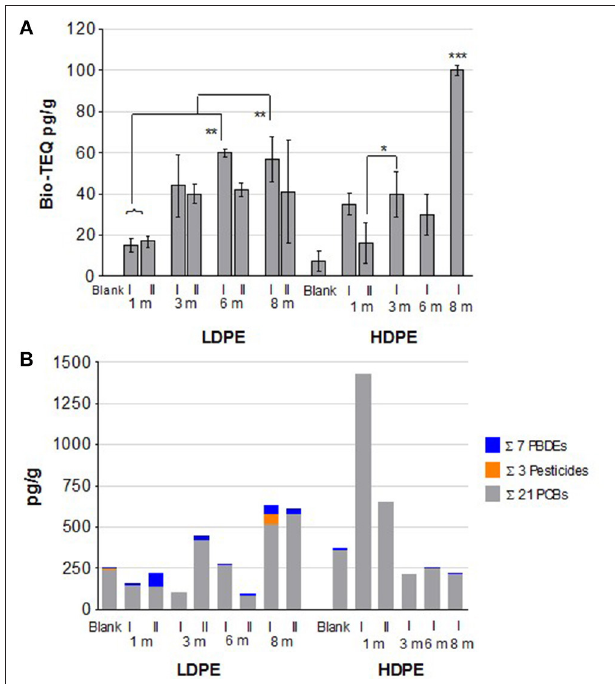
FIGURE 1 | Bioassay (DR CALUX ® ) and chemical analysis of extracts of deployed LDPE and HDPE pellets. (A) Bio-TEQs (EC 25 ) in pg/g calculated following a 24h exposure given as a mean of n replicates ( n = 3–4) and the standard deviation as error bars. Significance levels of ANOVA followed by Tuckey’s post hoc test are indicated as * p < 0.01; ** p < 0.001; *** p < 0.0001. (B) Sum of concentrations of detectable HOCs above LOQ in pg/g in